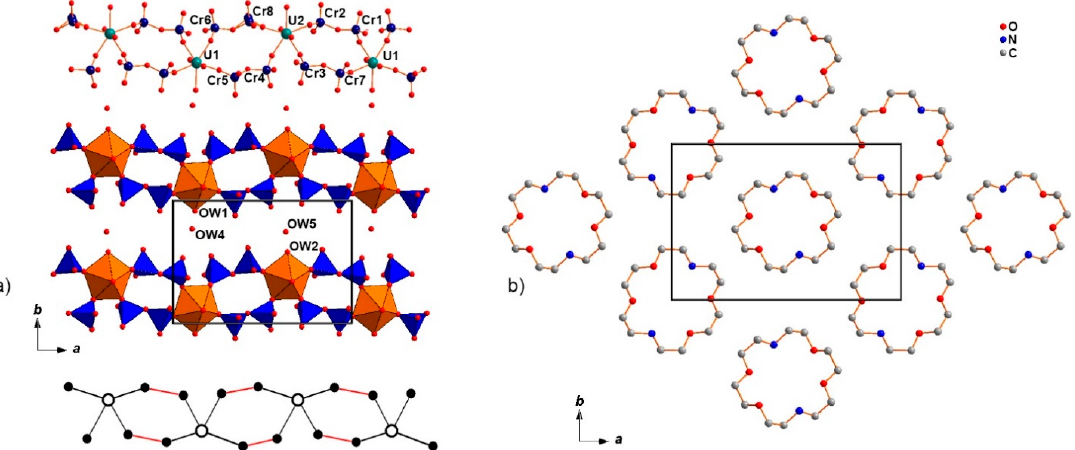
Figure 2. Ball-and-stick and polyhedral representation of [(UO 2 )(Cr 2 O 7 ) 2 (H 2 O)] 2 − uranyl-dichromate units in the structure of 1 ( a ) (designations: UO 7 = orange; CrO 4 = blue). Black-and-white graph (U = white circles, Cr = black circles) of the [(UO 2 ) 2 (Cr 2 O 7 ) 4 (H 2 O) 2 ] 4 − unit is given below. Red single lines highlight the Cr 2 O 7 groups. Arrangement of [H 2 diaza-18-crown-6] 2+ cations in the interlayer ( b ). Hydrogen atoms are omitted for clarity.